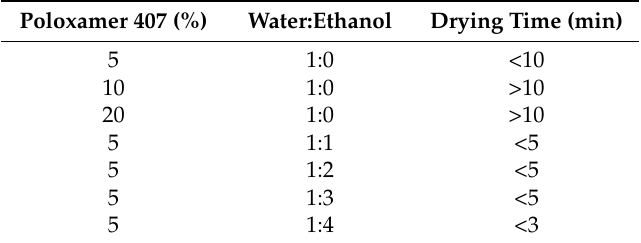
Table 3. Influence of the proportions of Poloxamer 407 and ethanol in the drying times of the developed lacquer bases. In all cases, the lacquers contained 10% MBCD and 10% NAC. Poloxamer 407 (%) Water:Ethanol Drying Time (min) 5 1:0 <10